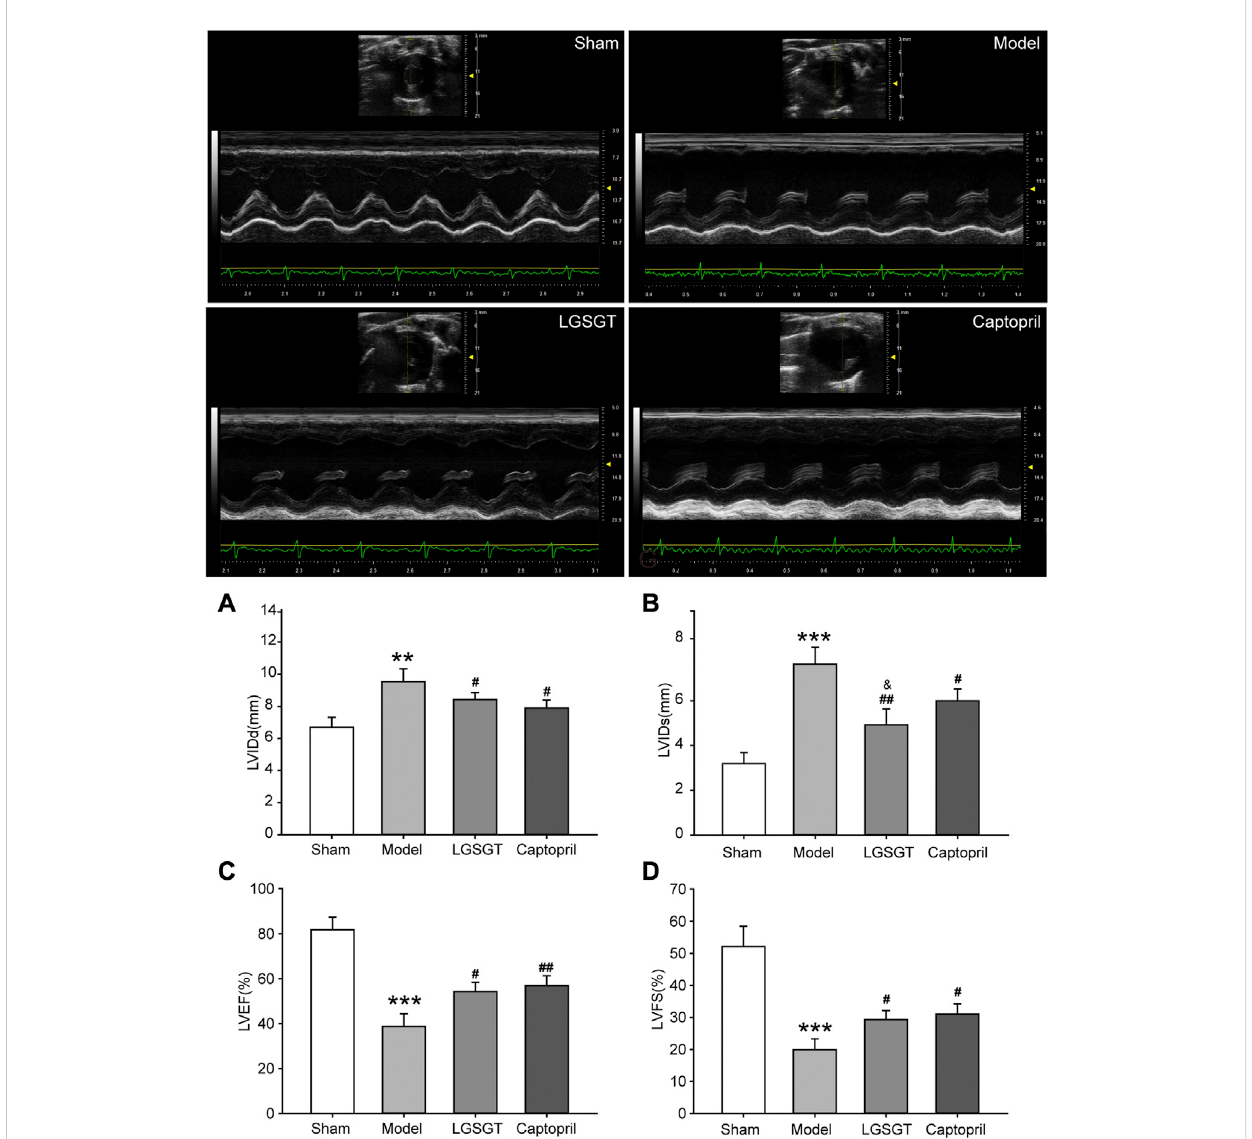
Linggui ZhuganDecoction improves cardiac functionin rats with chronic heart failure after myocardial infarction. Ventricular structure and ejection fractioninratswithheartfailuremeasuredbyechocardiography( n =9) (A – D) .* p < 0.05vs.shamgroup;** p < 0.01vs.shamgroup;*** p <